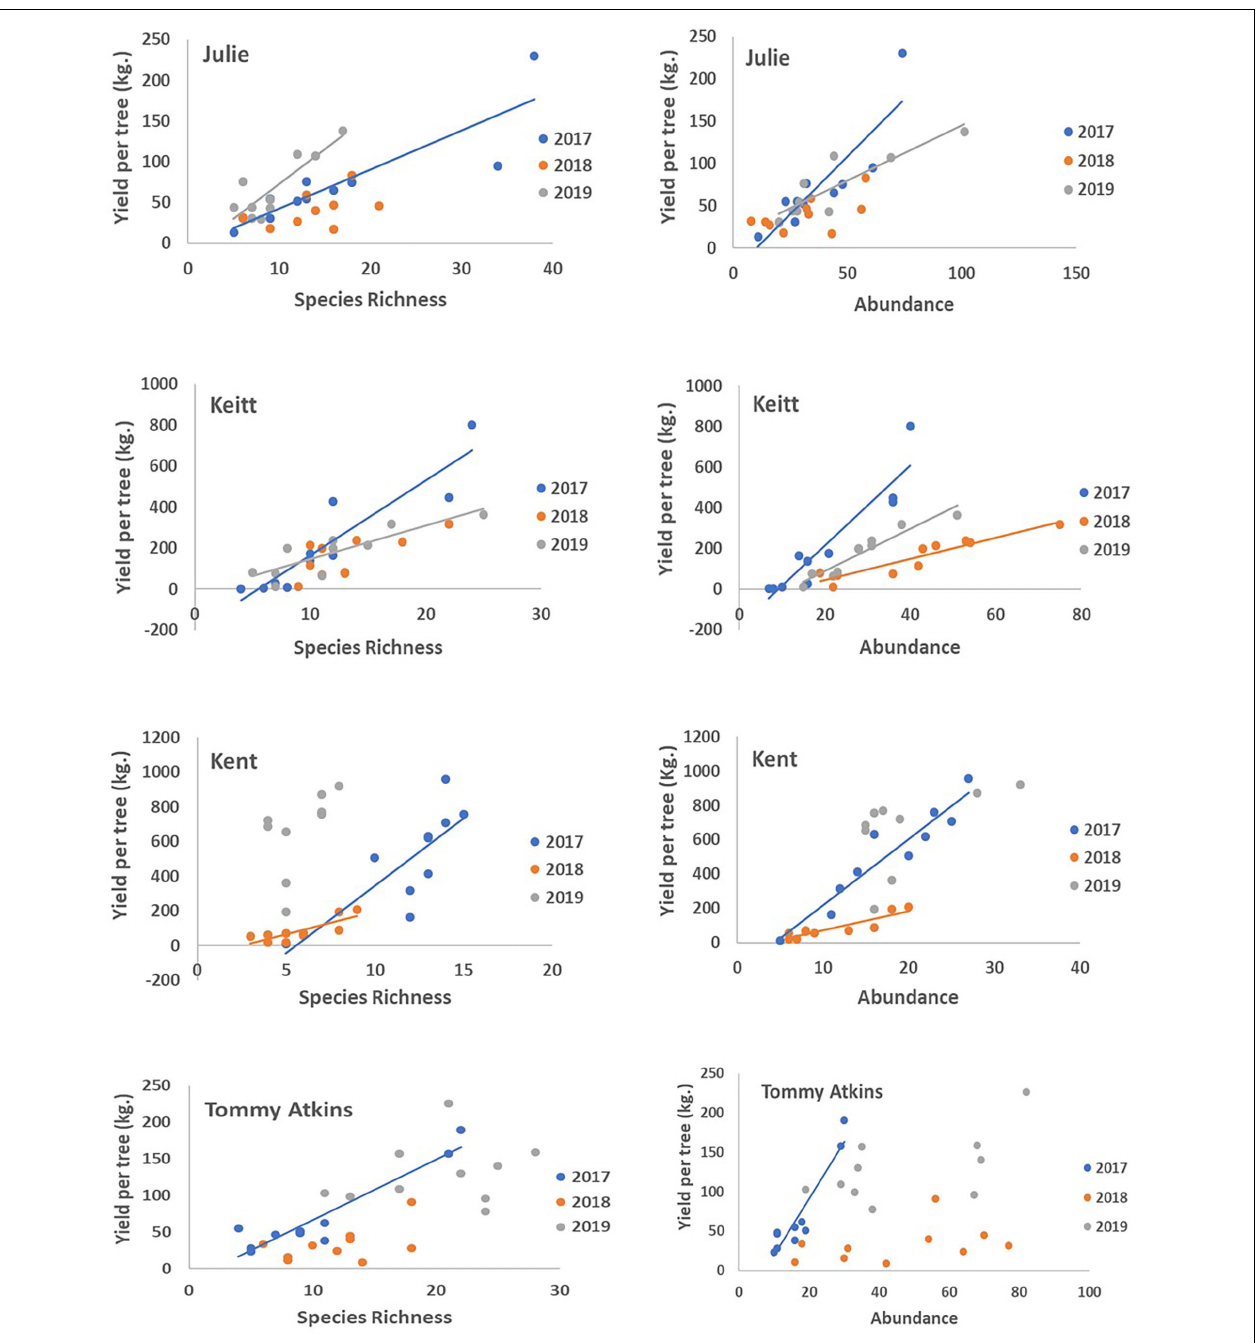
FIGURE 6 | Regressions of fruit yield as a function of global species richness and global insect abundance for four fields (Julie, Keitt, Kent, Tommy Atkins) across the 3 years of the study. For each field GLM analyses detected significant relationships between yield and insect richness and abundance in some years but not others ( Table 4 ). Lines represent the line of best fit from significant regressions at p <